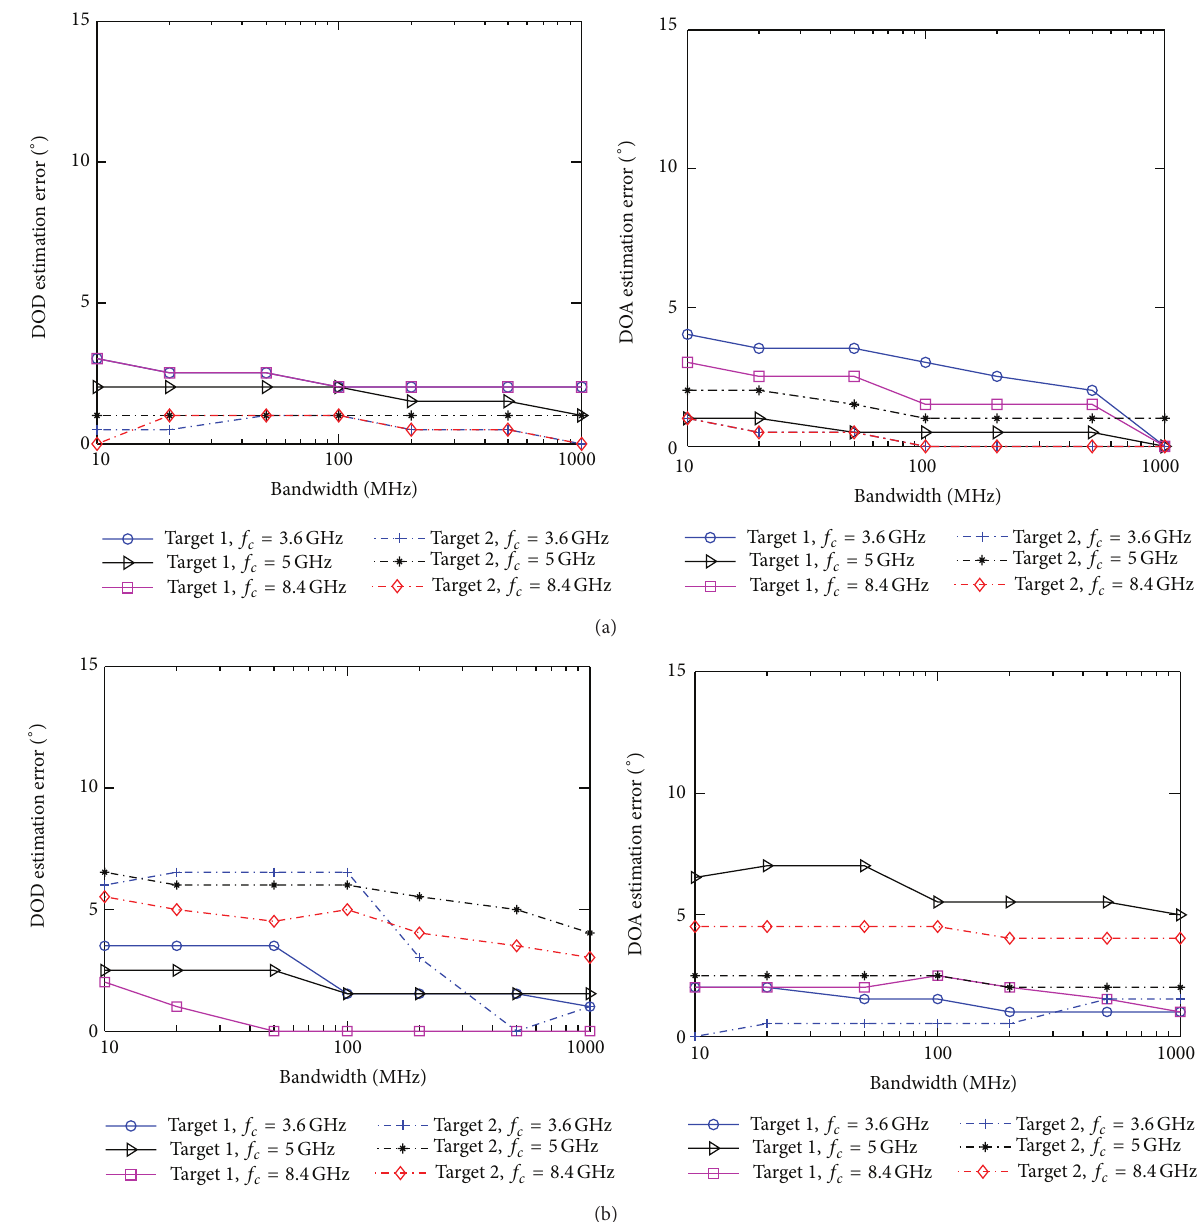
Figure 20: Estimation errors against bandwidth obtained from measurements: (a) spherical and (b) complex targets.